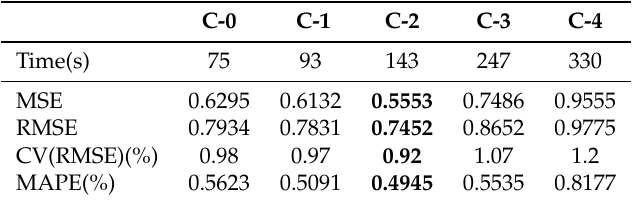
Table 1. Summary of accuracy metrics for RNN LSTM model forecasting: Chicago. Note: MSE, Mean Squared Error; RMSE, Root MSE; CV, Coefficient of Variation; MAPE, Mean Absolute Percentage Error.